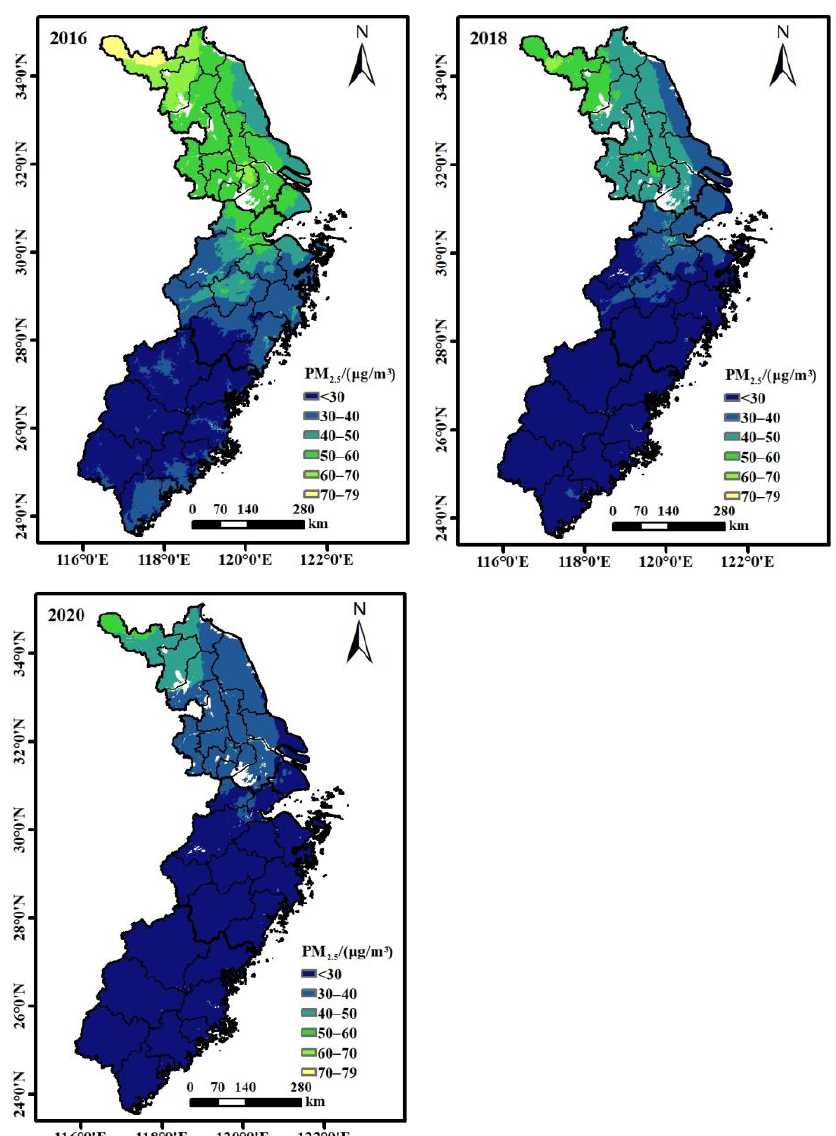
Figure 5. The PM 2.5 distribution of the YRD-FJ region from 2016 to 2020. At city scale, most of the cities witnessed the highest PM 2.5 concentrations in Jiangsu province (31–70 µ g/m 3 ), where Xuzhou was the most air polluted city with 3-year average PM 2.5 concentrations higher than 51 µ g/m 3 . The PM 2.5 concentrations of all cities were relatively low (19–31 µ g/m 3 ) in Fujian province. The highest value was located in Xia- men, with 3-year average PM 2.5 values of 26 µ g/m 3 , which was also much lower than those of cities in other provinces. At county scale, the 10 counties with the highest PM 2.5